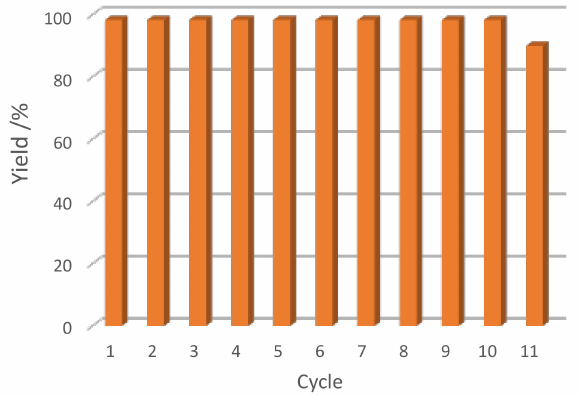
Figure 4. Effect of the number of catalytic cycles on the yield of the cyclic carbonate obtained by cycloaddition of CO 2 to propylene oxide catalyzed by [FeCl 2 { κ 3 -HC(pz) 3 }] in [bmim][N(CN) 2